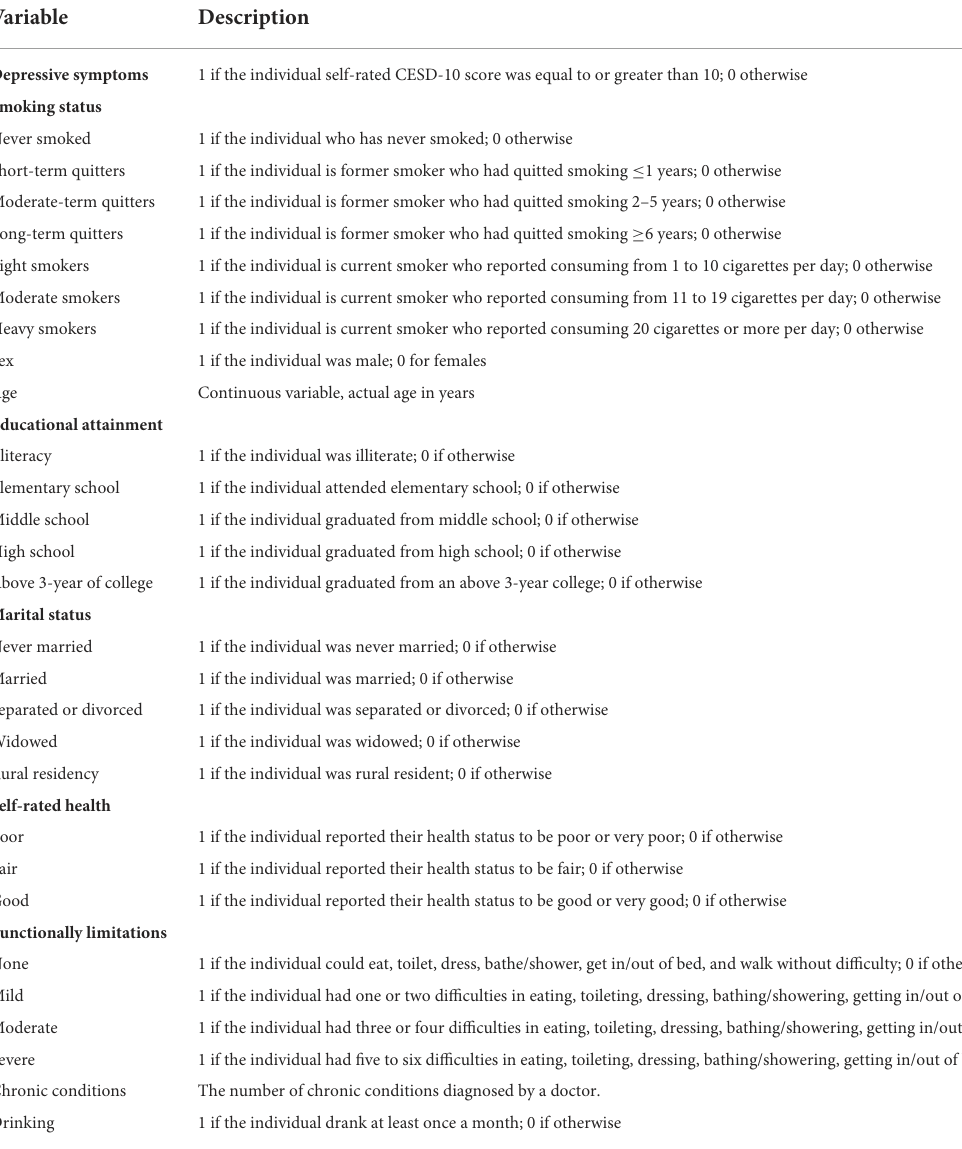
TABLE 2 Definitions of the variables used in the empirical models. Variable